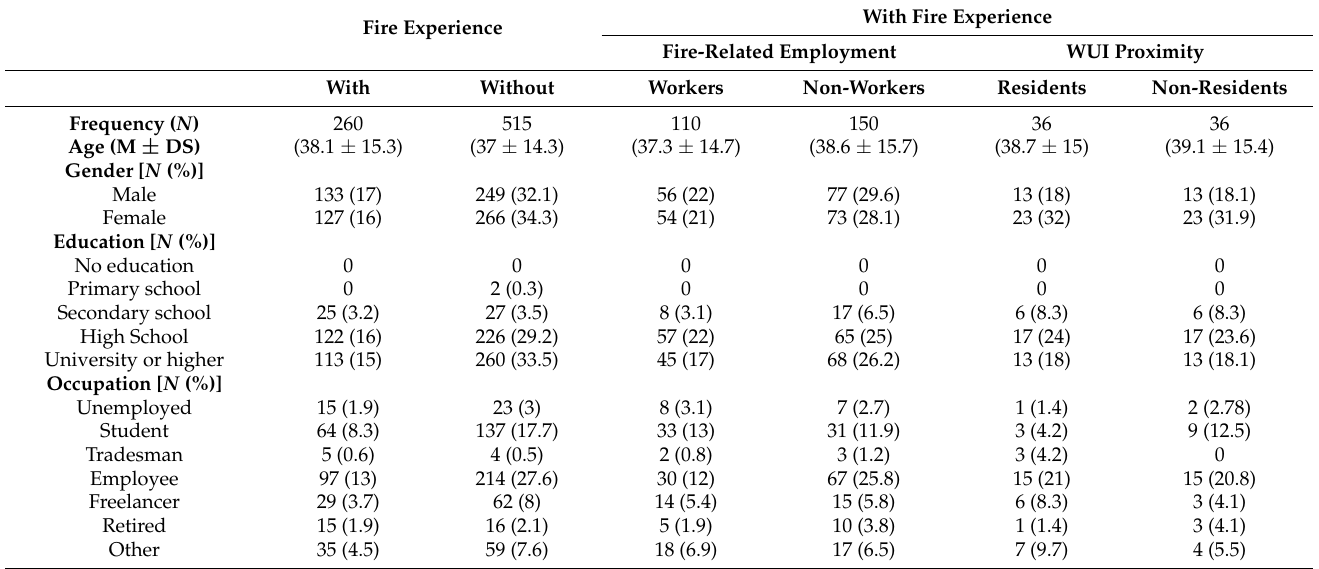
Table 1. Descriptive statistics of the six survey